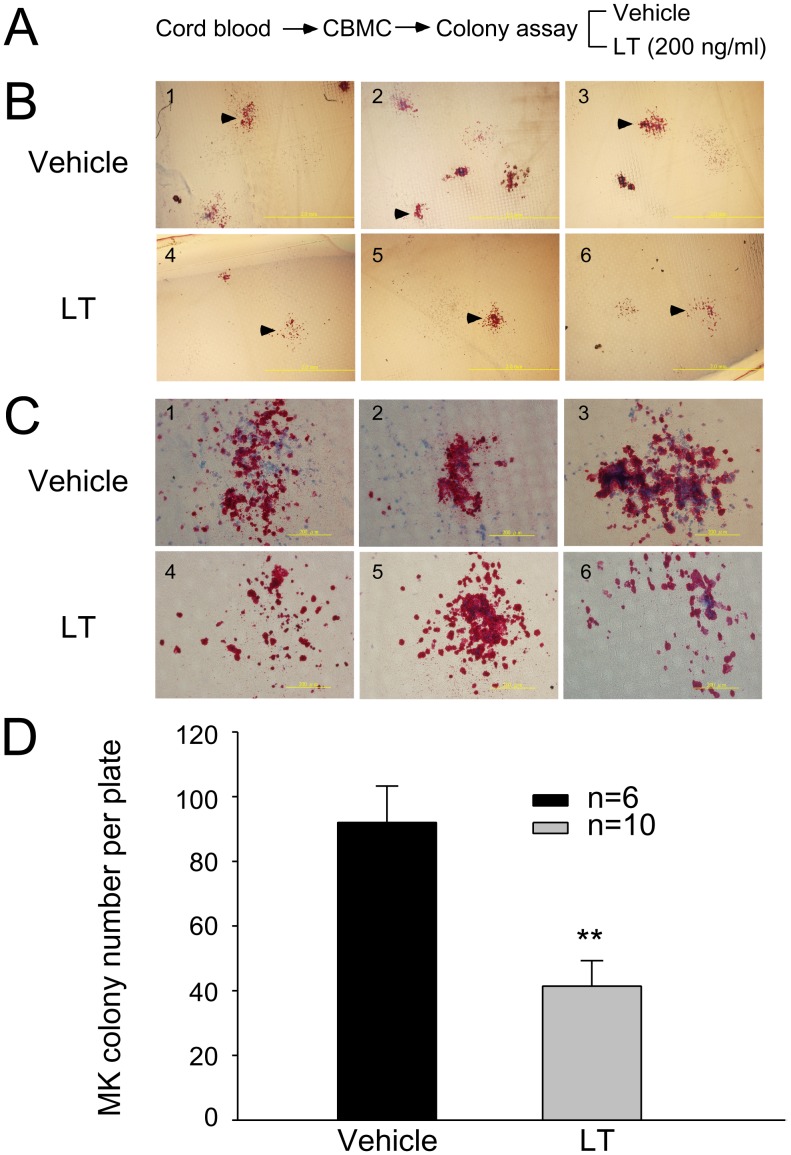
Suppressive effect of LT on CFU-MK formation.(A) The experimental outline. Human cord blood-derived mononuclear cells (CBMCs) were used in a megakaryocytic colony-forming unit (CFU-MK) assay. This figure shows the morphology (B–C) and quantified numbers (D) of megakaryocytic colonies. Arrowheads in the low magnification images (B-1 to B-6) indicate specific colonies that are highlighted in high-magnification photographs (C-1 to C-6) for each group (C). Scale bar: B, 2 mm; C, 200 µm. The cell-culture medium was used to dilute LT and was used as a treatment control in vehicle-groups. Data are representative of 3 independent experiments. One plate was seeded with 1.1×105 cells. Data are reported as mean ± standard deviation (SD), **p<0.01 compared to vehicle groups.